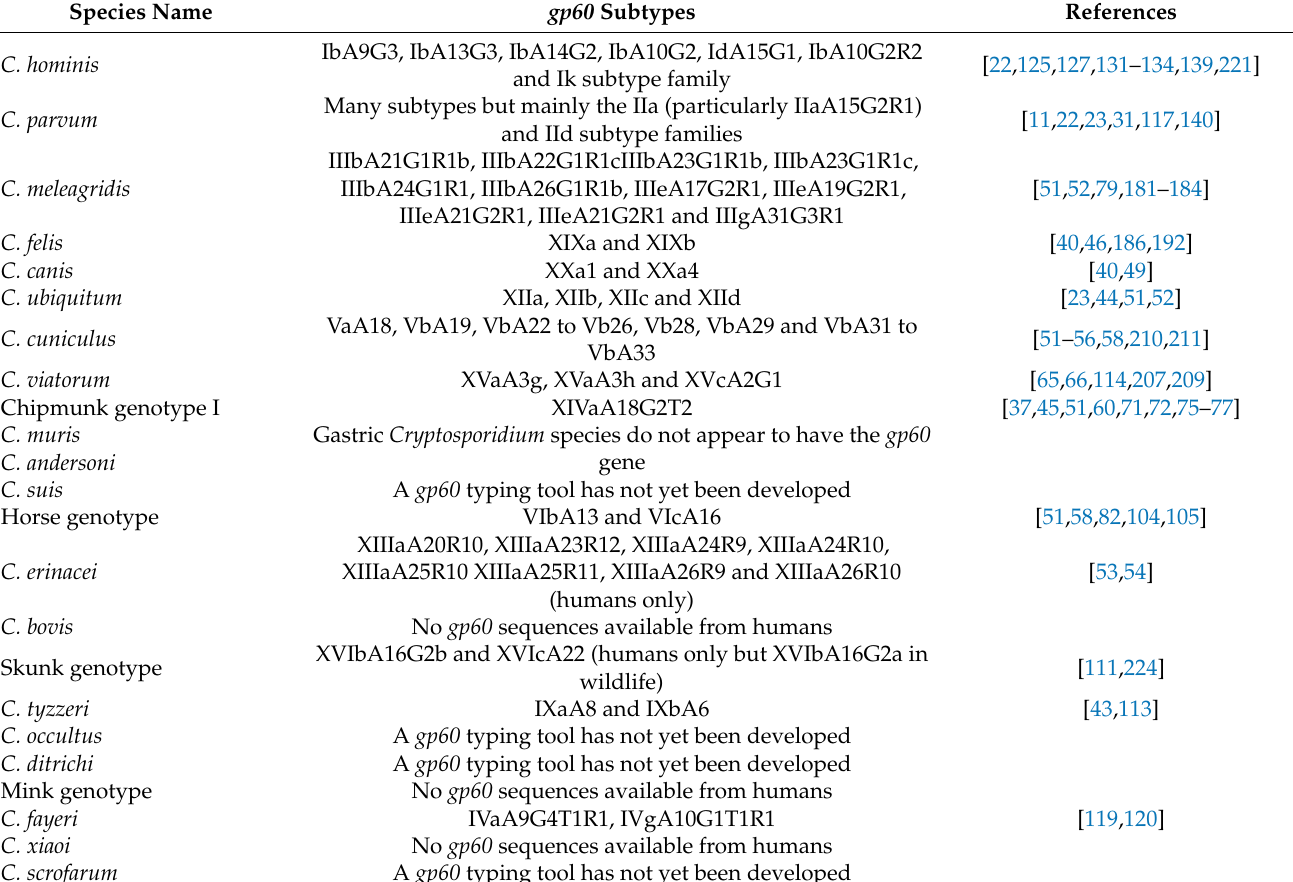
Table 2. Zoonotic gp60 subtypes common to humans and animals (excluding non-human